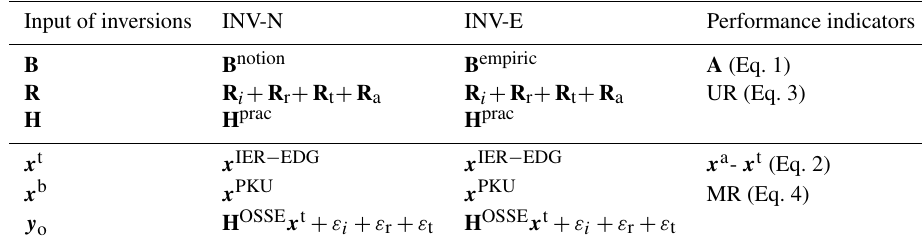
Table 2. Notations for the eight OSSEs.